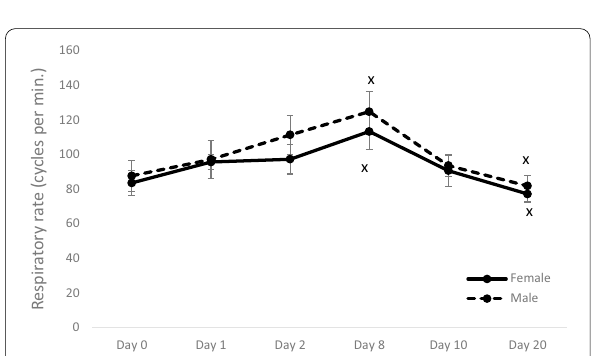
Values with a, b for the overall data are significantly different P < 0.05